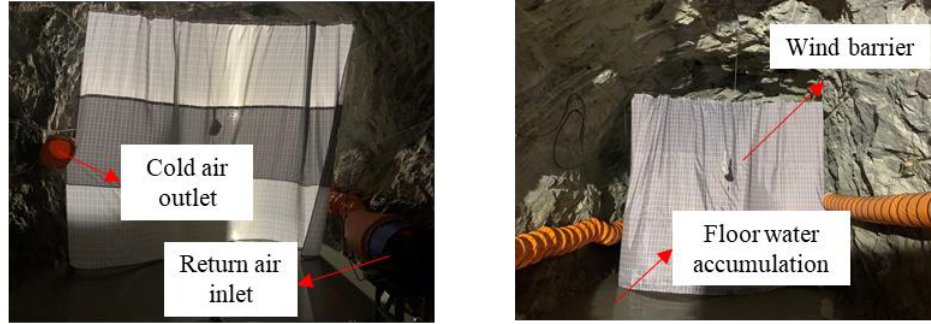
Figure 3. Layout of the test site.